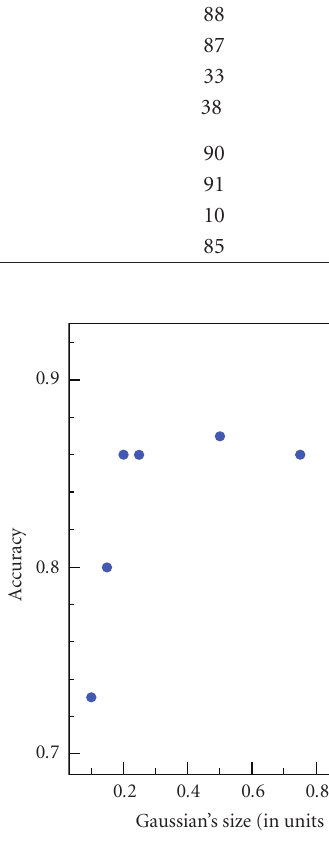
Figure 6: Variation of the system’s accuracy with the occupant’s dynamics, modeled by the Gaussian function’s σ . Table 5: Variation of accuracy and mean belief with